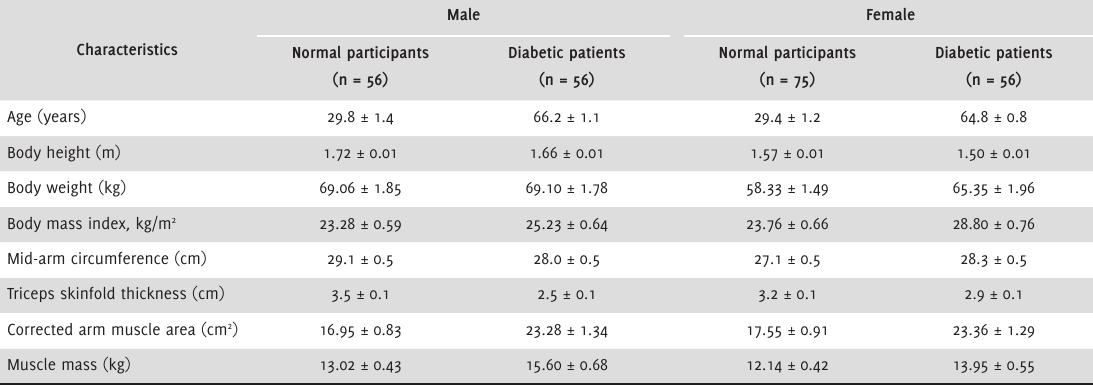
Values are means ± standard